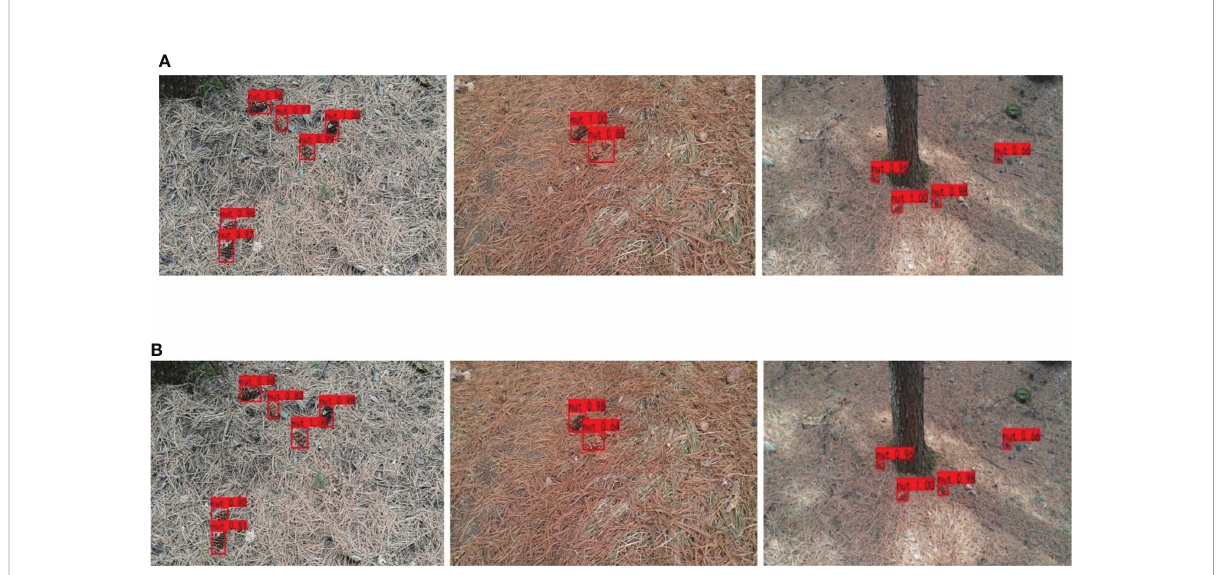
FIGURE 11 Detection results of YOLOv4 and EBE-YOLOv4: (A) Detection based on YOLOv4; (B) Detection based on EBE-YOLOv4.